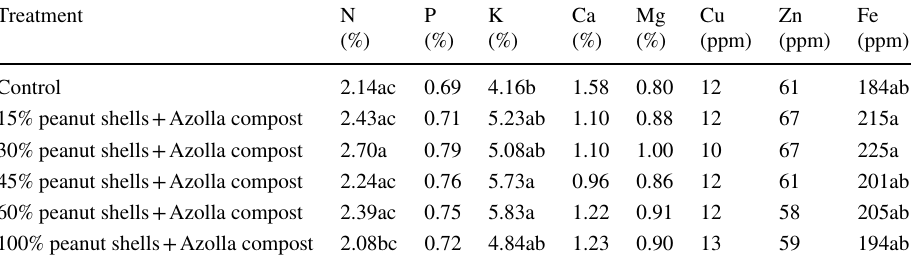
The means of the same letters do not significantly differ ( p ≤ 0. 05